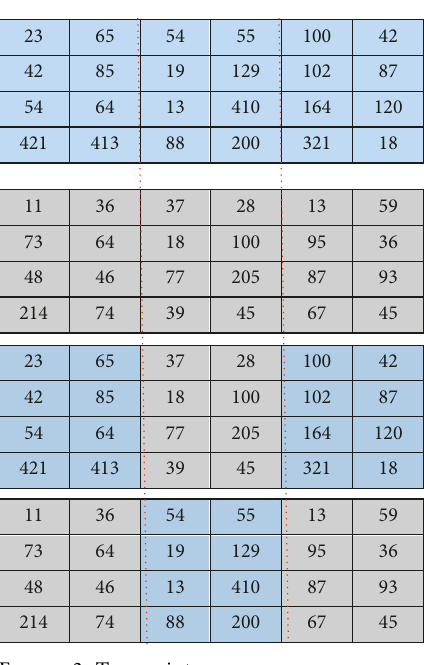
Figure 3: Two-point cross over.